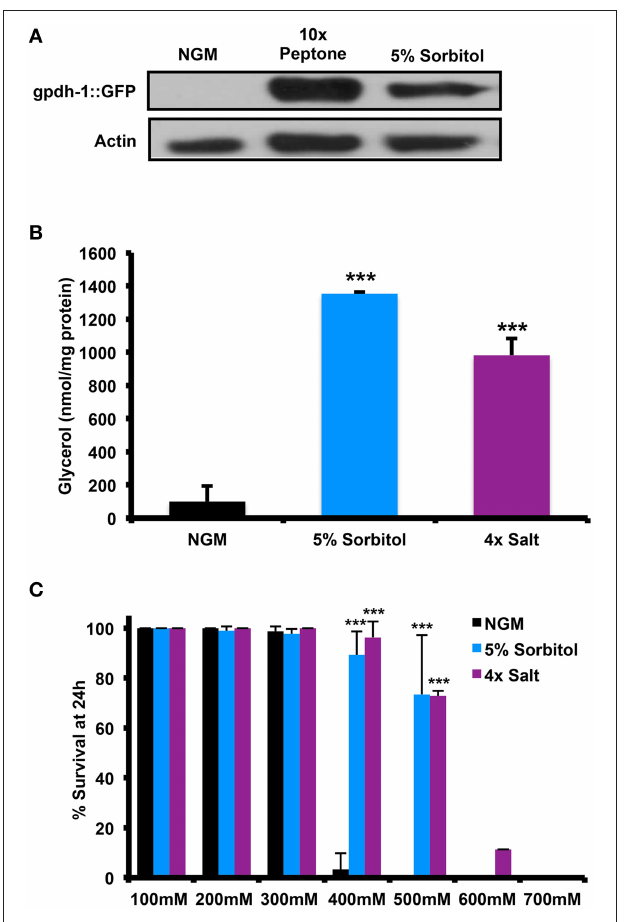
FIGURE 2 | Effect of Sorbitol on the accumulation of glycerol and resistance to high salt stress. (A) Animals grown in medium containing 10X peptone or 5% sorbitol induce expression of the glycerol-3-phosophate dehydrogenase reporter pgdh-1::GFP, as determined by immunoblot analysis for GFP. (B) Whole animal glycerol levels were elevated in wild-type (N2) worms were grown on 5% sorbitol or 4X NaCl relative to controls ( *** p < 0.05 , t -test). (C) Either 5% sorbitol or 4X NaCl is sufficient to confer resistance to higher levels of NaCl through osmotic pre-adaptation ( *** p < 0.05 , t -test).